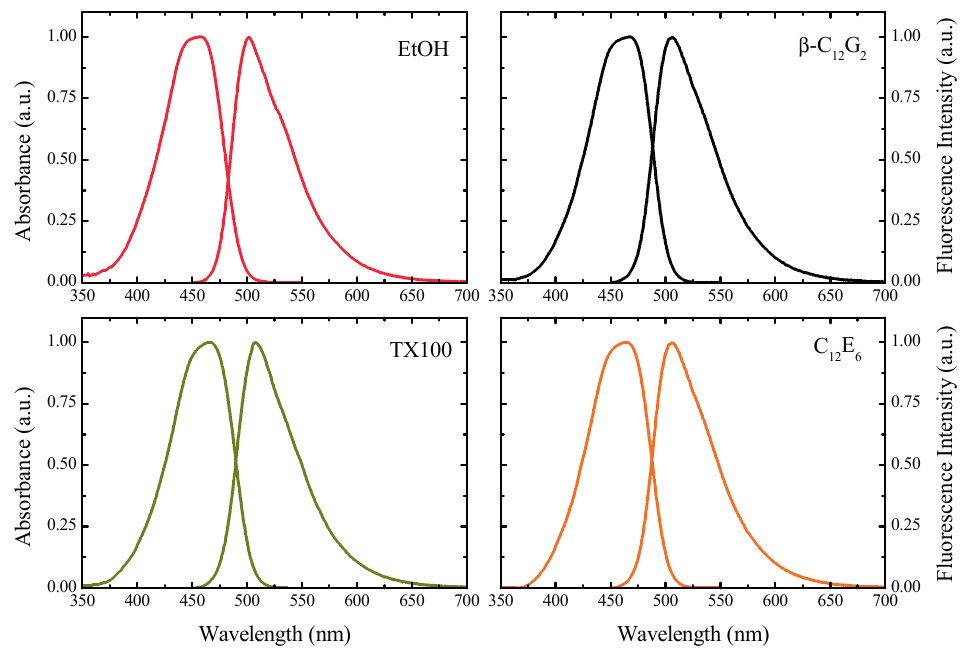
Figure 2. Absorption and steady-state emission spectra of C6 in ethanol (EtOH) and in different micellar media. The probe concentration was about 5 μ M, and that of the surfactants in all cases was 20 mM. The excitation wavelength employed in all cases was 465 nm. Table 1. Absorption, ( λ abs ) max , and emission maxima, ( λ em ) max , quantum yields, Φ f , fluorescence lifetimes, τ f , and the radiative ( k r ) and nonradiative ( k nr ) decay rate constants of Coumarin 6 (C6) in ethanol (EtOH) and in different micellar media at 25 °C.